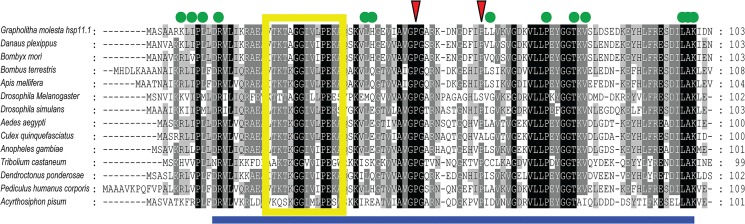
Alignment of Hsp11.1 of G. molesta with thirteen other insect species.The predicted secondary structure of the Cpn10 superfamily is underlined by a blue solid line. Red arrows show two roof hairpins. Yellow boxes indicate a mobile loop, and green dots indicate 13 putative oligomerisation interfaces.